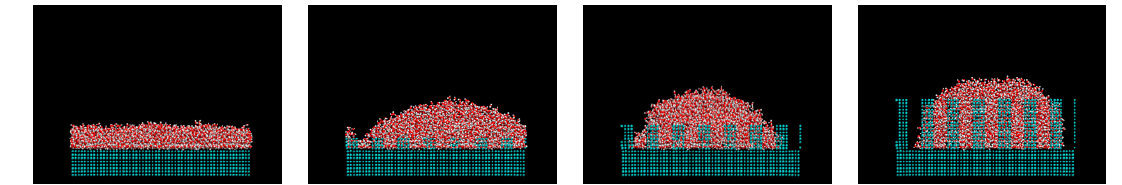
Figure 7. Droplets on nanostructures with ε = 3.948 kJ/mol. Figure 6. Snapshot of the water film on the flat and nanostructured surfaces with the Lennard-Jones parameter ε = 19.74 kJ/mol (the left upper: 2259 water molecules, others: 3787 water molecules).